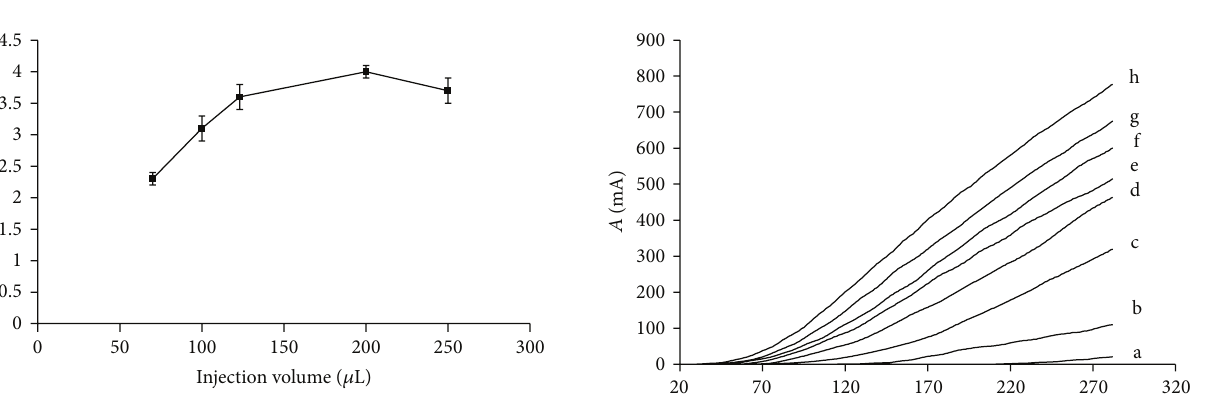
Figure 5: Injection volume effect on the reaction rate using pectin standard corresponding to 5.7mM methanol. Table 2: Preincubation time effect on the reaction rate using pectin standard corresponding to 5.7mM methyl esters.